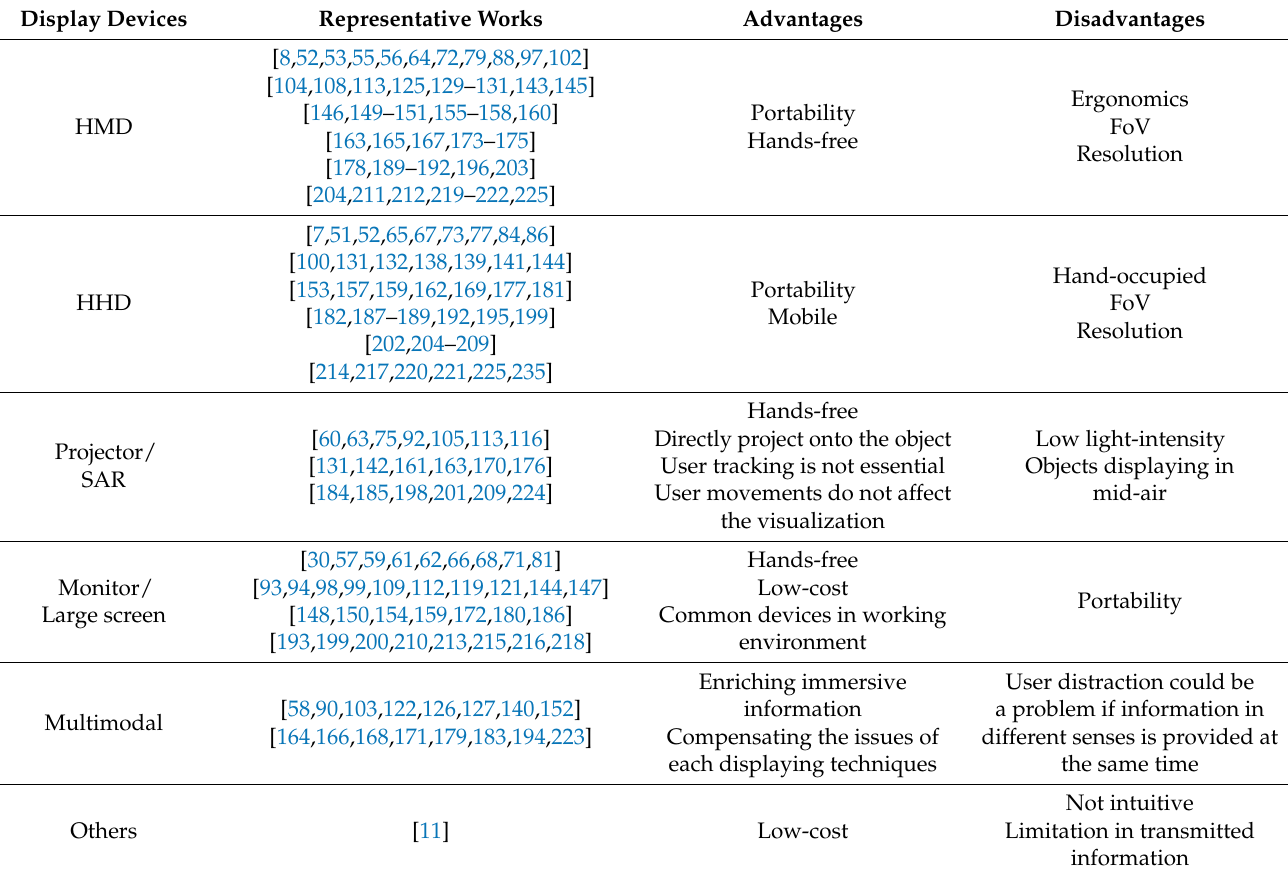
Table 13. Articles on Layer 2 Implementation-sublayer Hardware from 2010–2021.